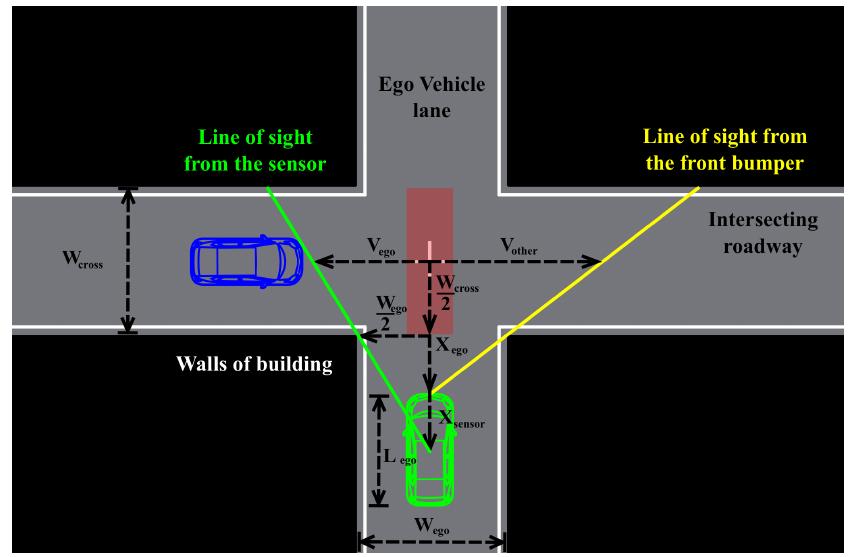
Figure 3. A simple, blind intersection model. The red shaded area represents the overlapping travel zone where a collision could potentially